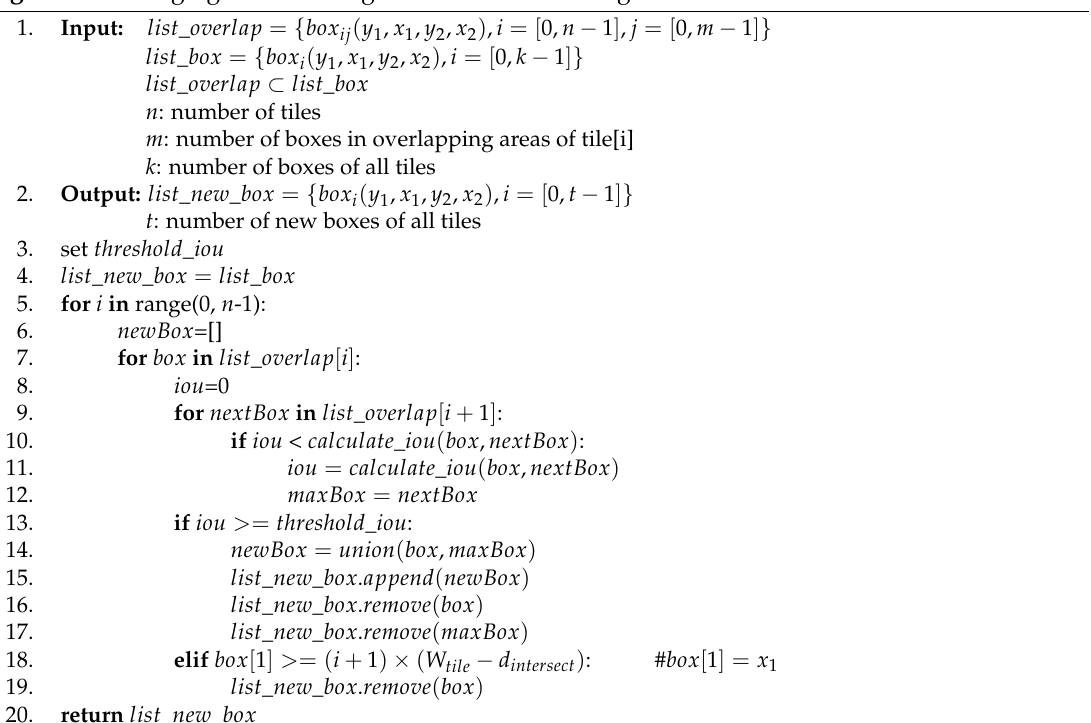
Algorithm 1 Merging the bounding boxes of each tile image in the initial